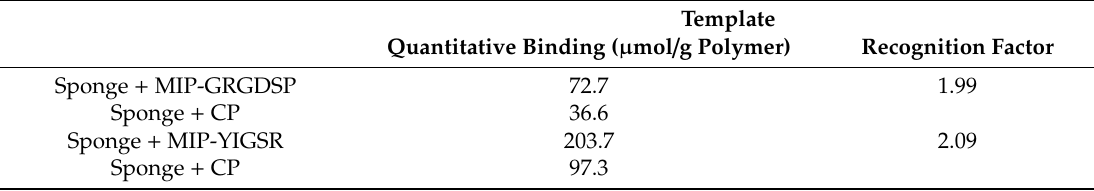
Table 6. Results of recognition tests performed on AGE sponges functionalized with MIP-GRGDSP and MIP-YIGSR, and relative controls (sponge +